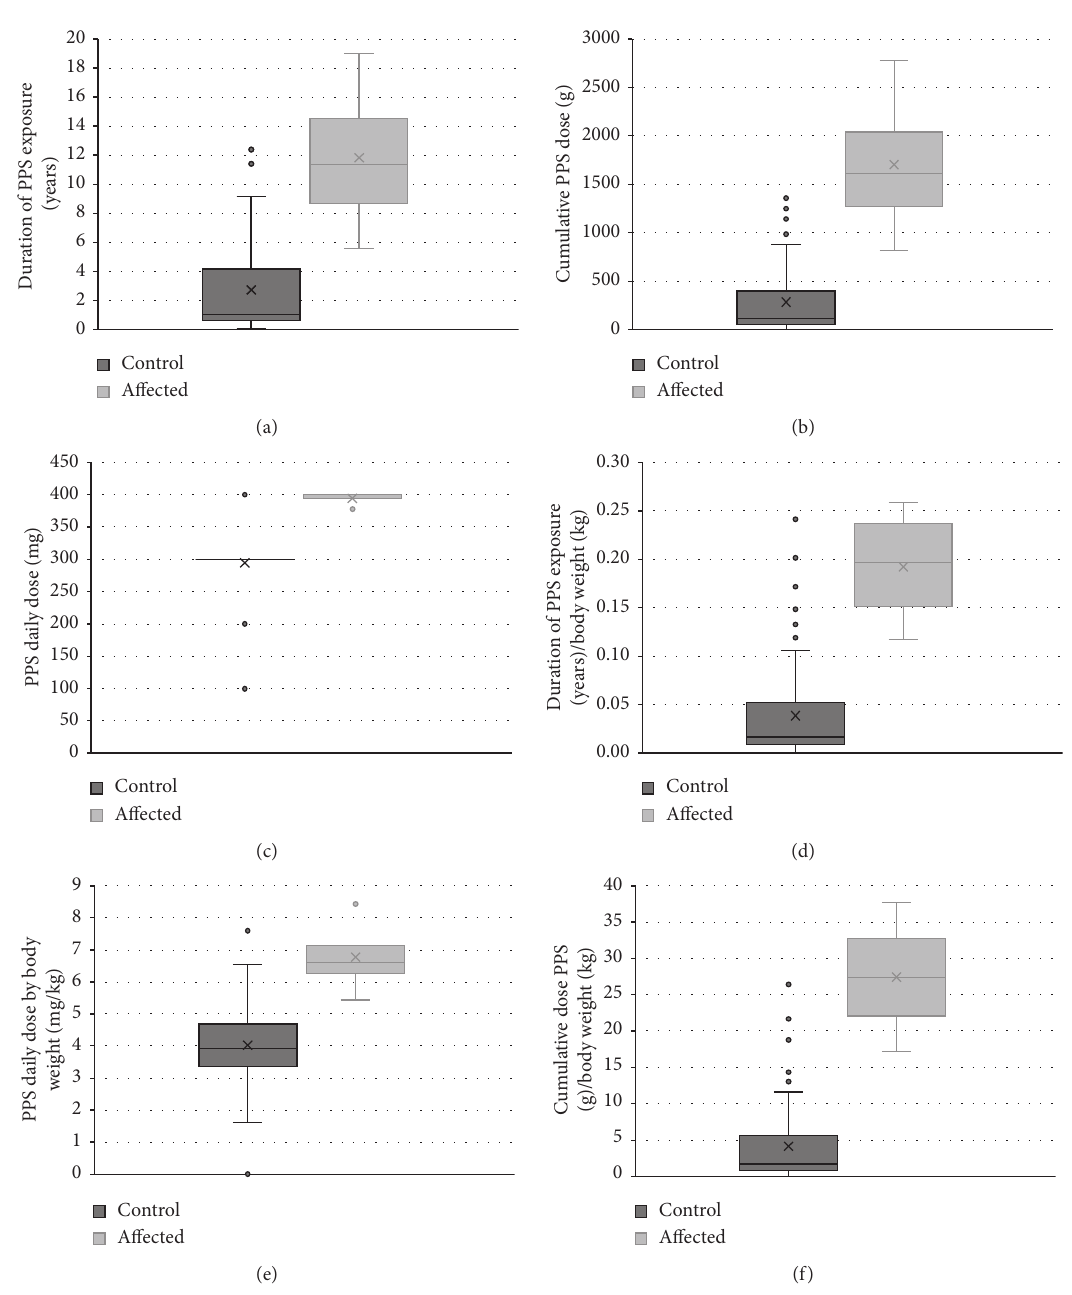
Figure 1: Patients affected by PPS maculopathy ( n � 4) compared to control patients taking PPS without known maculopathy ( n � 93). Duration of PPS exposure, also when considered by body weight, was higher in affected patients compared to controls. The daily dose of PPS was higher in affected patients compared to controls (middle row, left). Cumulative PPS exposure, also when considered by body weight, was higher in affected patients compared to controls (bottom row). Box plots show median center line in box, 1st and 3rd quartile edge of boxes, and end of lines showing minimum and maximum. Dots outside of the bars represent outliers. X in the boxes represents the mean. P values are results from two-tailed t -test. (a) P � 0 . 05. (b) P � 0 . 04. (c) P � 6 . 0 e − 7. (d) P � 0 . 02. (e) P � 0 . 02. (f) P � 0 .